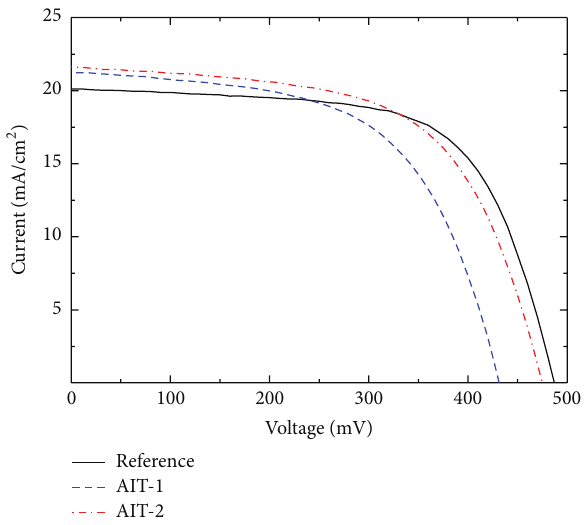
Figure 8: External quantum efficiency of 𝜇 c-Si:H thin-film solar cells processed on the reference superstrate and on the AIT-2 superstrate (the corresponding short-circuit current is indicated in the